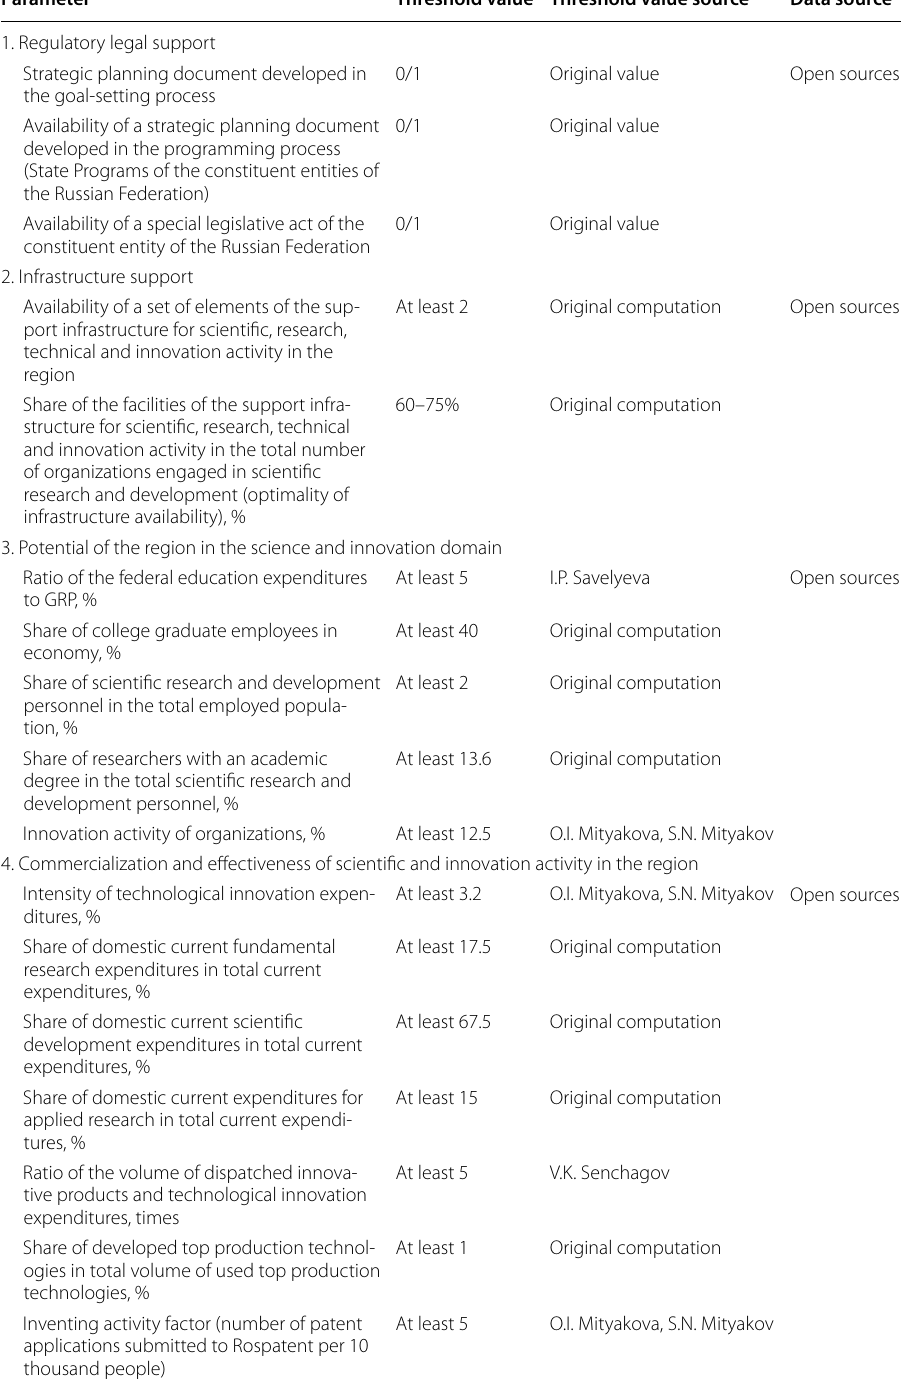
Table 1 Parameters for evaluating the support infrastructure for scientific, research, technical and innovation activity in the region by differentiated aspects